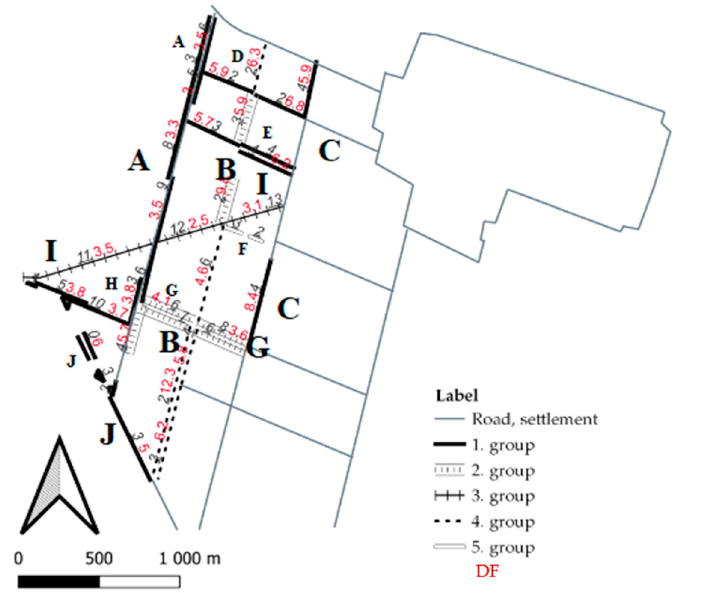
Figure 1. Map of the sampled verges.